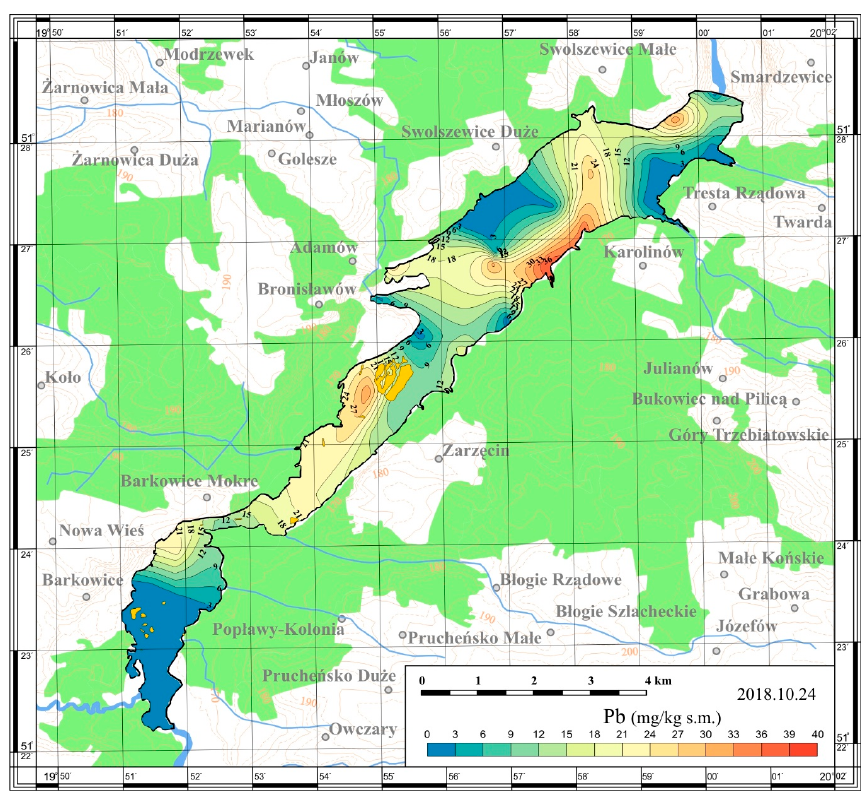
Figure 10. Spatial distribution of lead in bottom sediments of the Sulejów Reservoir.